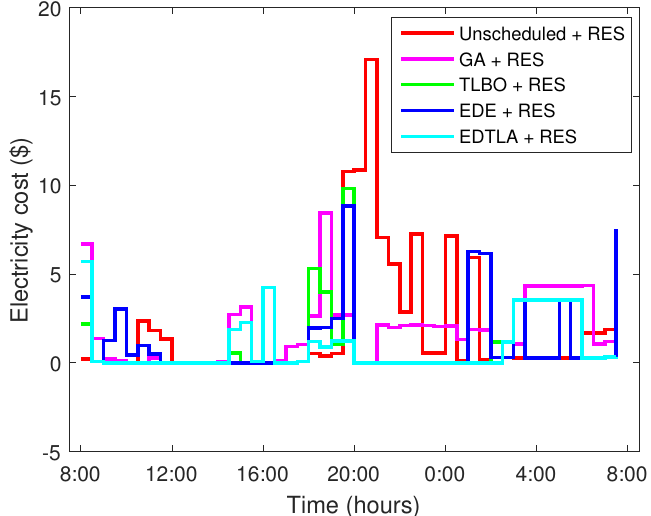
Figure 16. Hourly electricity bill with RESs and BSS.